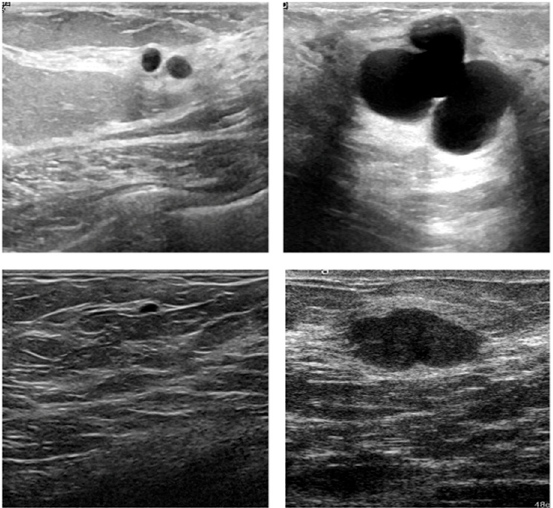
Figure 2. Image samples for training: top row, from Dataset A, and bottom row, from Dataset B.